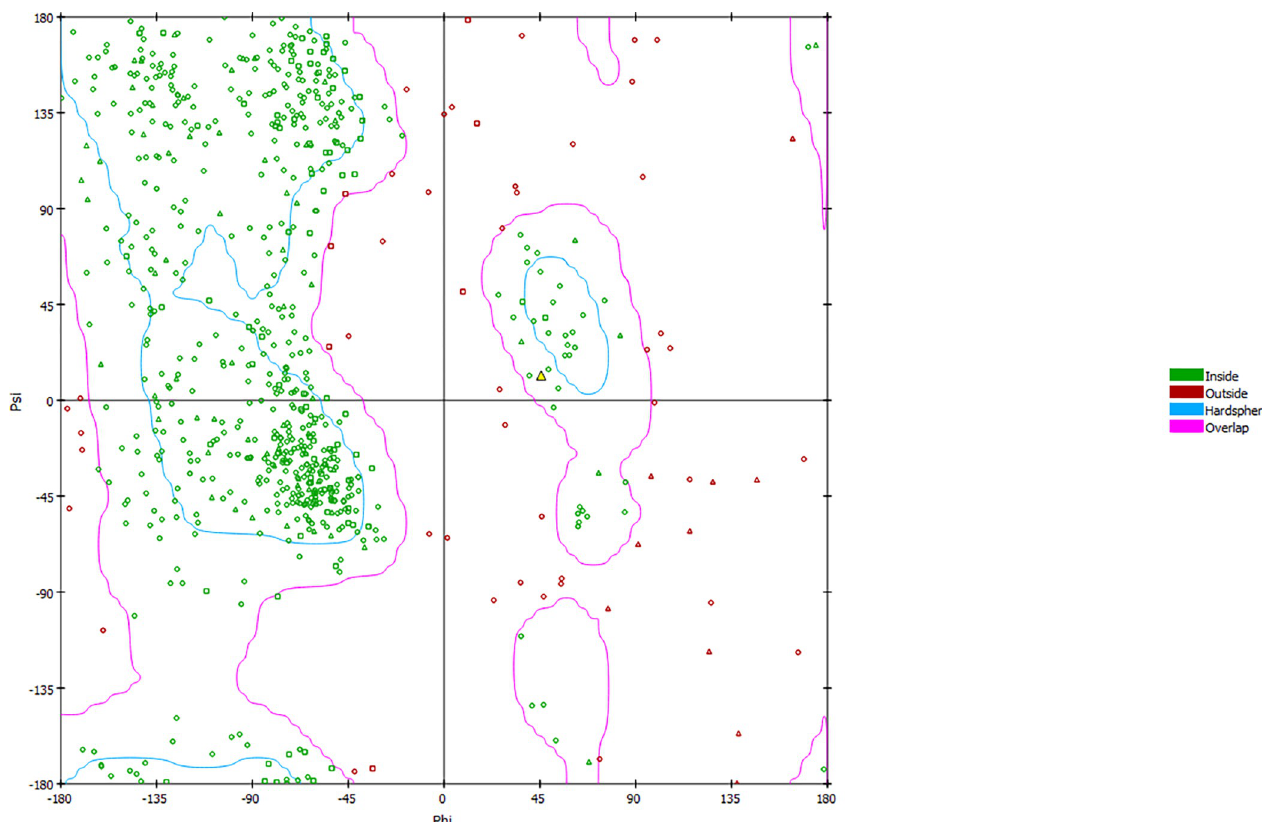
Fig 3. Quality of designed 3D structure of SIX5 protein was evaluated using Ramachandran plot. Overall, 90% residues lie inside allowed regions with a few residues as an outlier, their Phi and Psi angles are not perfectly